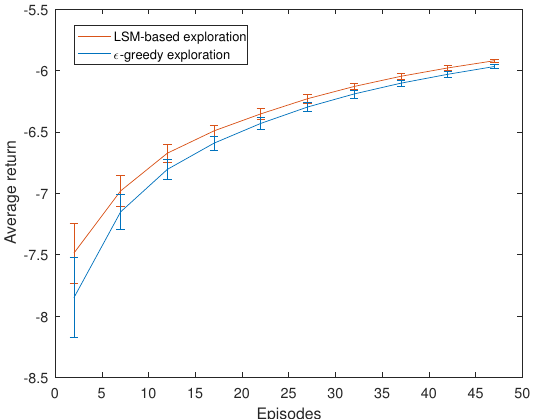
Figure 7. Learning curves for the mountain car problem. The curves are smoothed with a window of five episodes with an error bar at every five